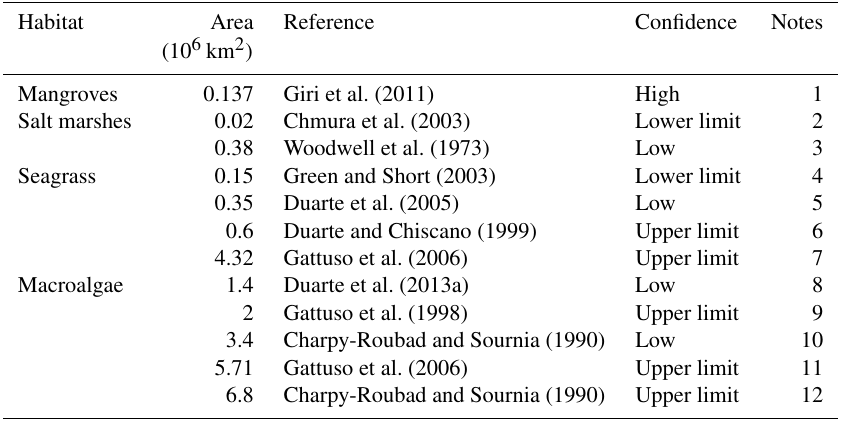
Table 1. Estimates of the global area covered by vegetated coastal habitats, indicating the level of confidence in the estimates and whether they represent lower or upper limit